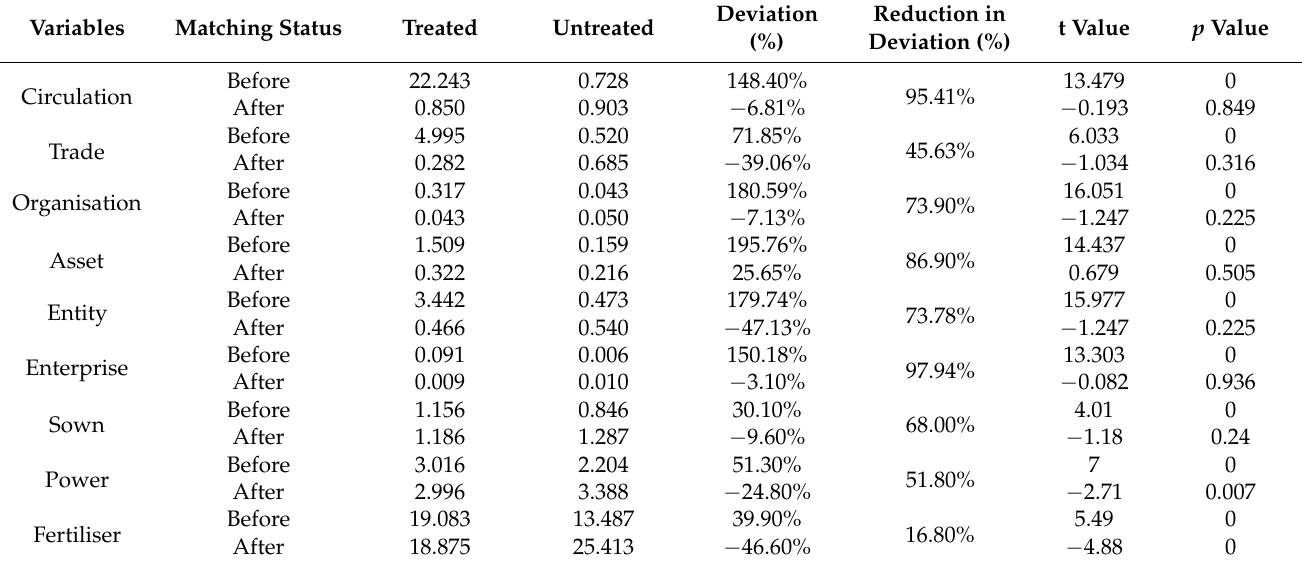
Table 3. Comparison of sample characteristics of PSM matching effects for treated and control